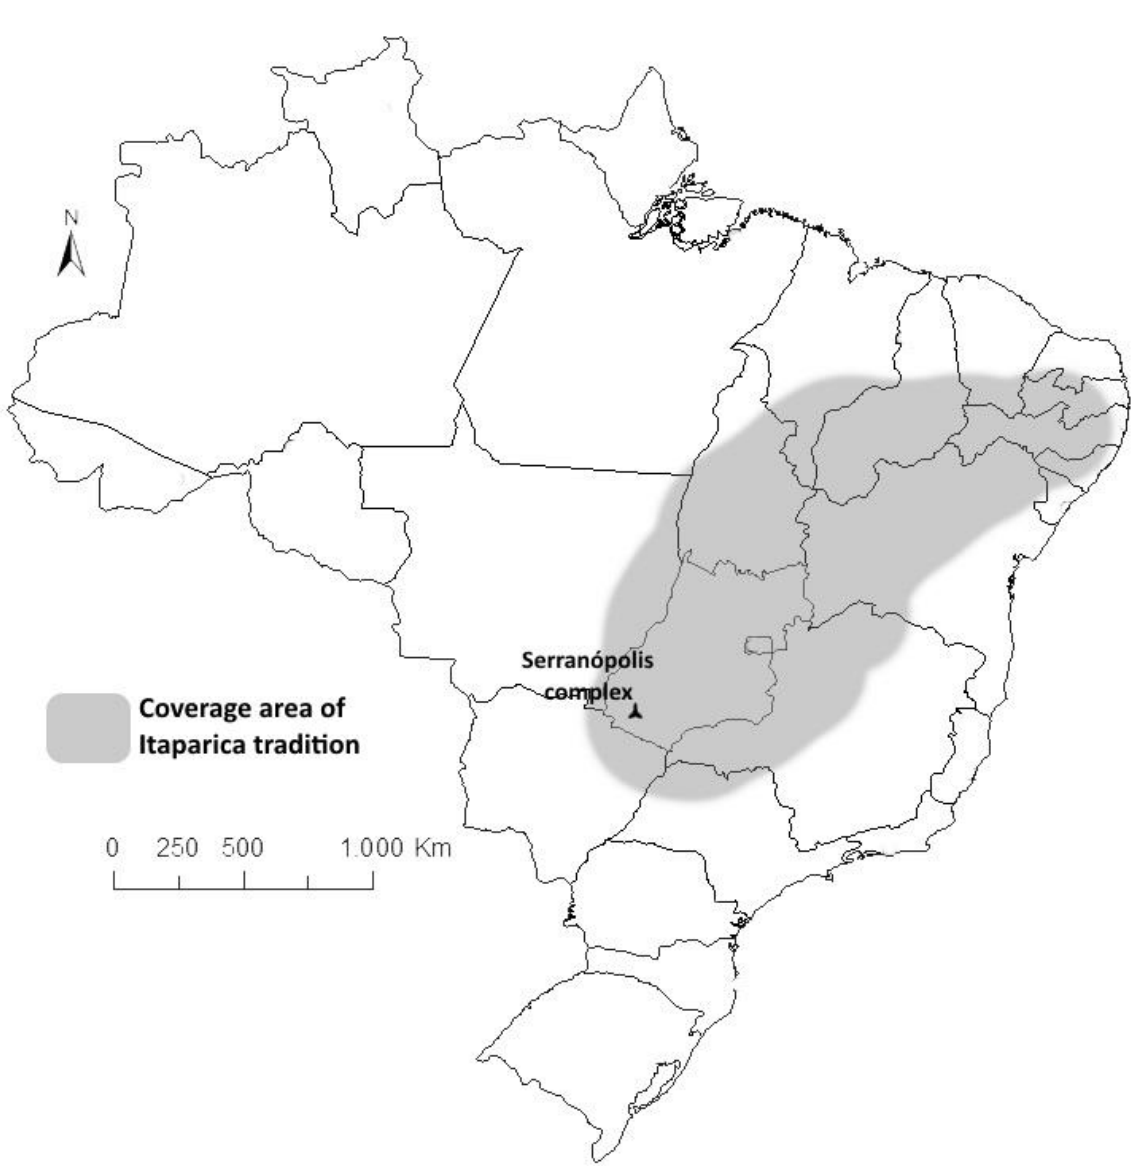
Figure 1. Map of Brazil with the researched location and the coverage area of Itaparica